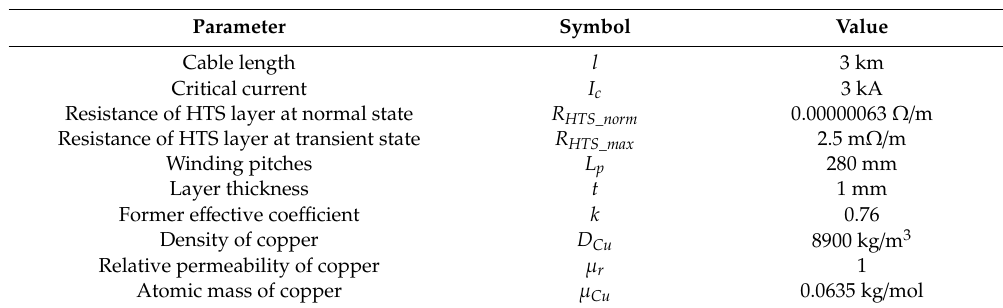
Figure 9. Tested system. Table 2. HTS cable parameters.